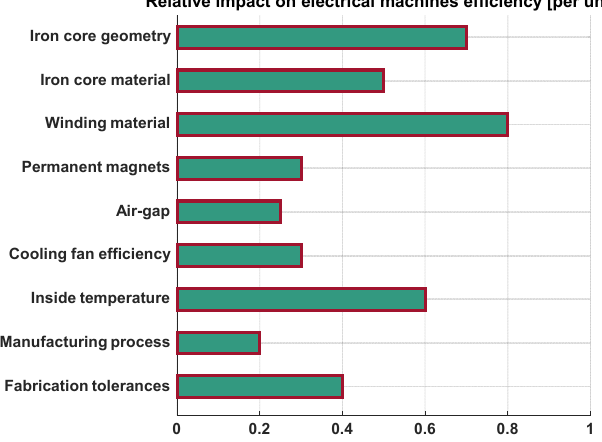
Figure 13. Impact of various advancements concerning the efficiency of EMs.